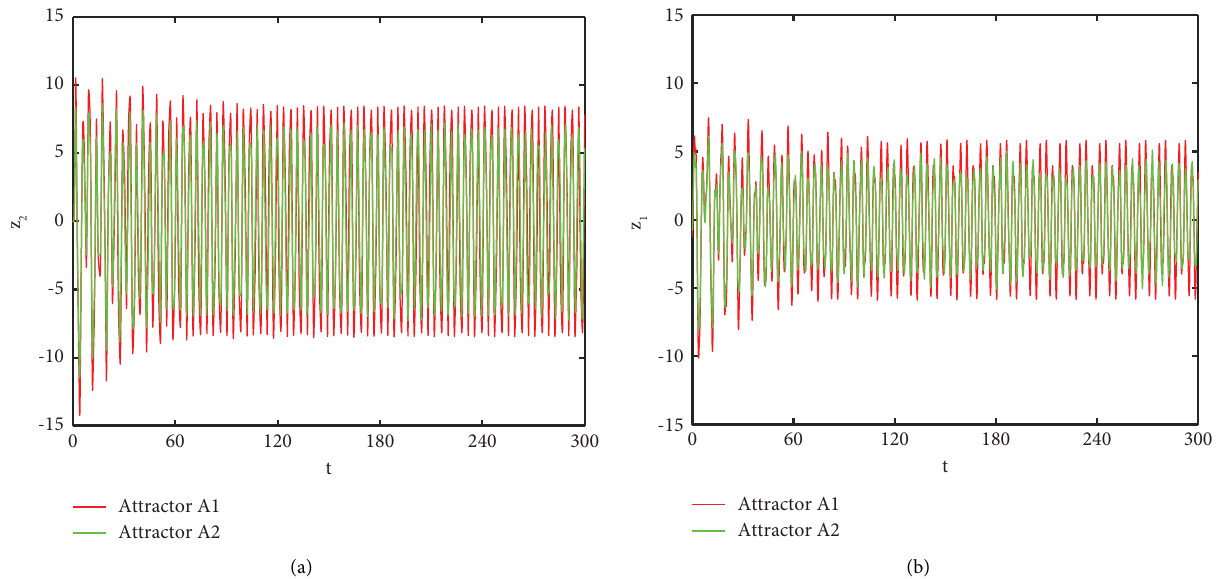
Figure 11: Te time history of the system responses under diferent initial conditions. (a) Te mechanical equipment vibration response. (b) Te NES vibration response.